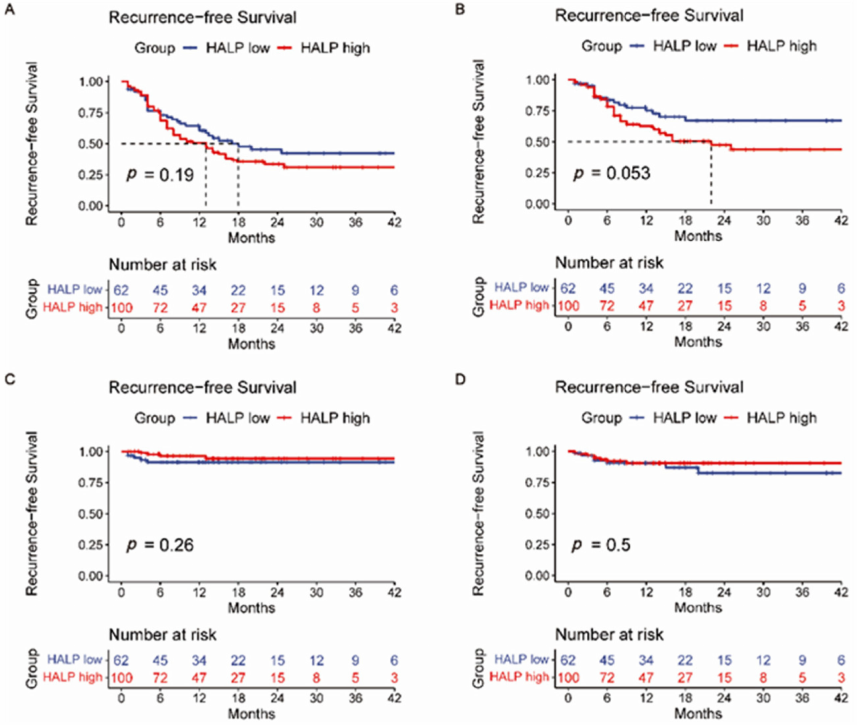
Figure 3. The value of HALP score in predicting ( A ) recurrence-free survival, ( B ) intrahepatic recurrence, ( C ) lymph node metastasis, and ( D ) distant metastasis